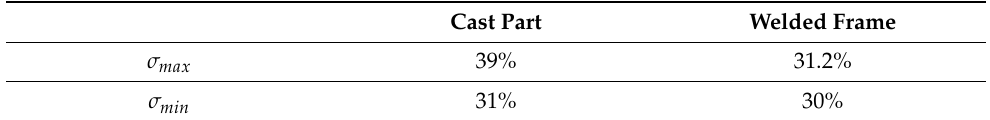
Table 3. Maximum and minimum stress values on the components [30] (stress values were scaled as a percentage of yield points of materials). Cast Part Welded Frame σ max